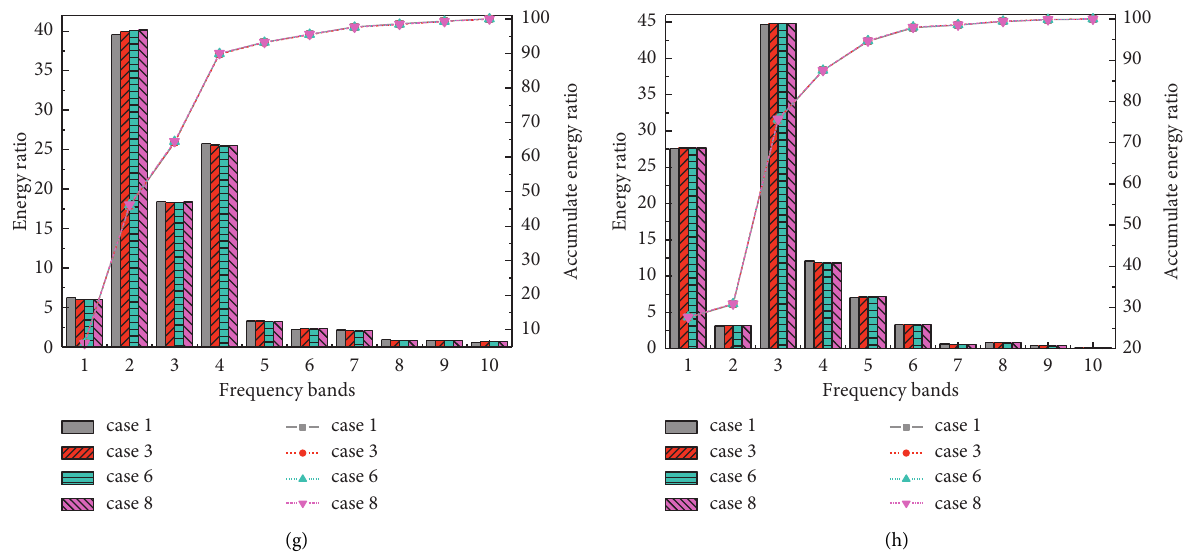
Figure 6: The Hilbert marginal energy ratio spectrum of IRF and VIRF (the second time test at excitation point I). Point 1: (a) IRF. (b) VIRF. Point 7: (c) IRF. (d) VIRF. Point 12: (e) IRF. (f) VIRF. Point 25: (g) IRF. (h)